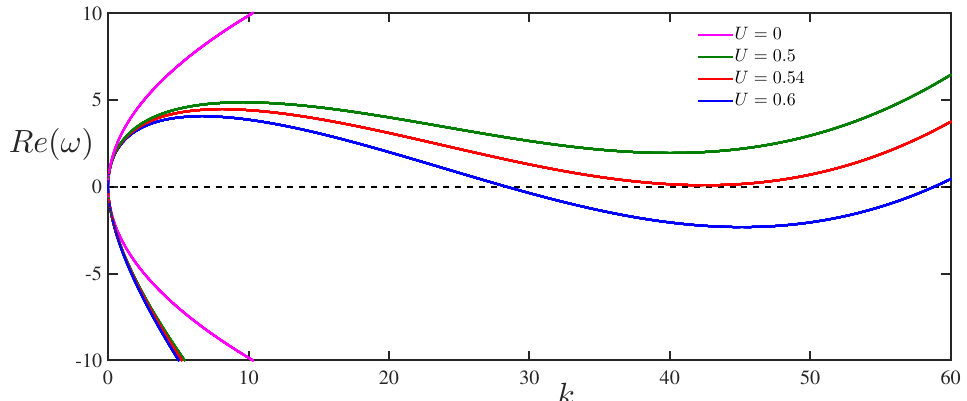
Figure 7. Dispersion relation (14) in the frame co-moving with the upper layer (air) for a few values of U